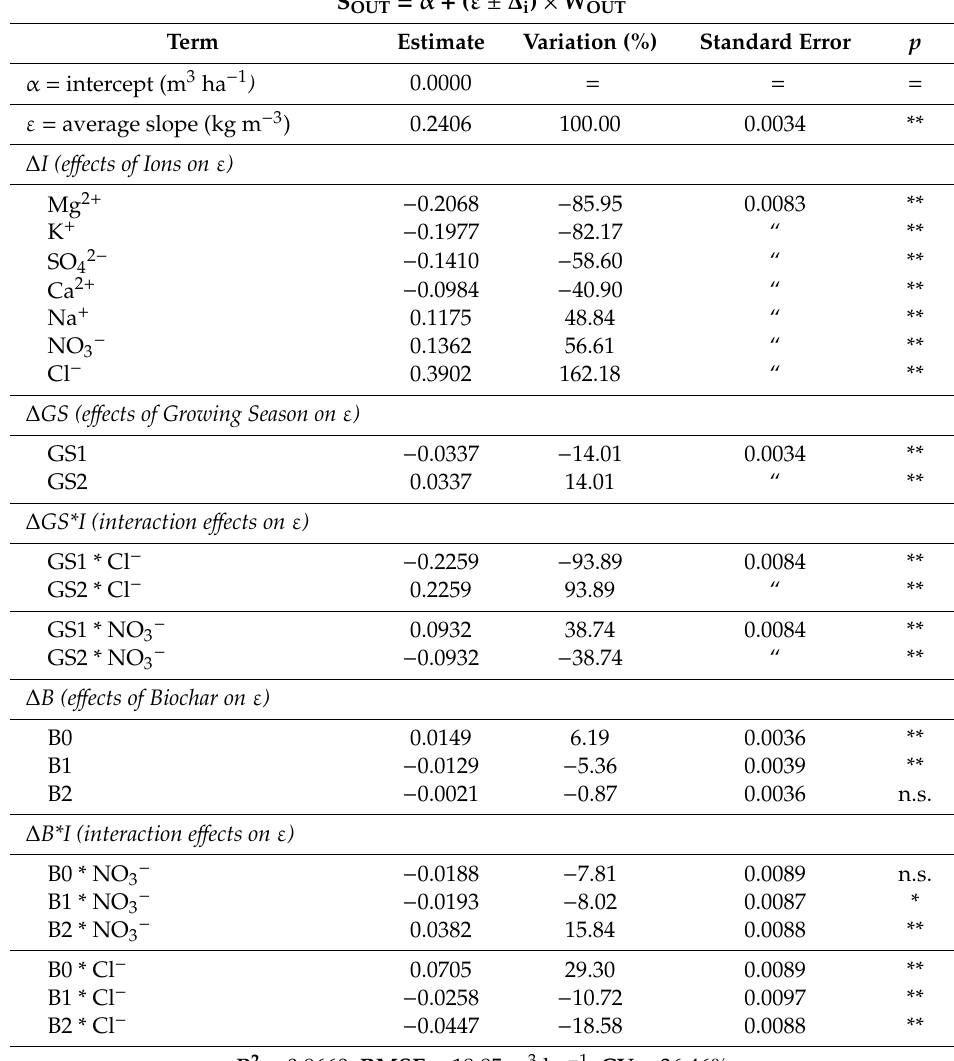
Table 3. Statistical results of the ANCOVA leaching model (see the first table line for the equation). The coe ffi cient estimates, their percentage variation with respect to the average slope, standard errors and their corresponding probabilities are shown. Summary of fit is also reported in the lower part of the